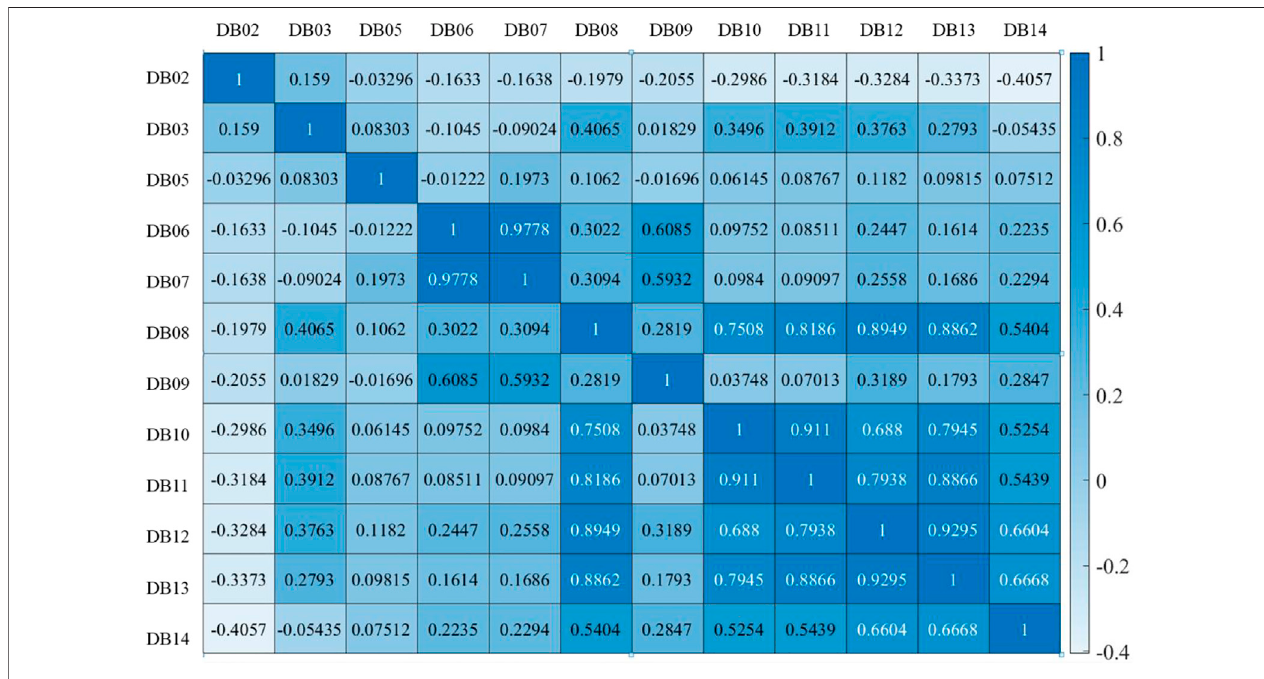
FIGURE 2 | Spatial-temporal correlation matrix with Pearson ’ s correlation coef fi cient.